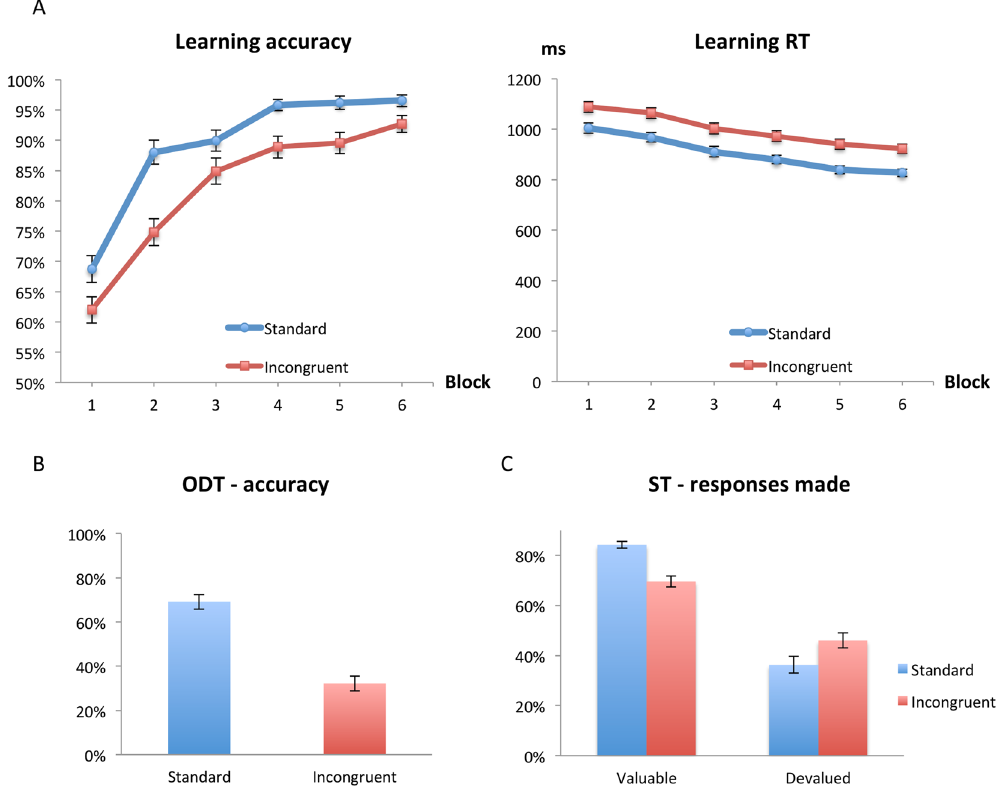
Figure 2. Behavioral results. ( A ) Subjects’ accuracy and reaction time are displayed for the learning phase. Subjects rapidly learned both discriminations and reached high levels of accuracy at the end of six blocks. Their responses gradually became faster in both conditions, and overall they were significantly faster in the standard condition. ( B ) In the Outcome Devaluation Test, subjects’ responses to outcomes from standard pairs were more accurate (than incongruent). ( C ) Percentage of the responses made during the Slip Test is shown for valuable/devalued outcomes in both conditions. Subjects responded less often when the outcomes were devalued in both conditions, however, there was a significant interaction of Value X Discrimination, i.e., subjects responded for devalued outcomes more often and responded for valuable outcomes less often during incongruent trials. Error bars represent the standard error of the mean. Abbreviations: RT: reaction time, ODT: Outcome Devaluation Test, ST: Slip